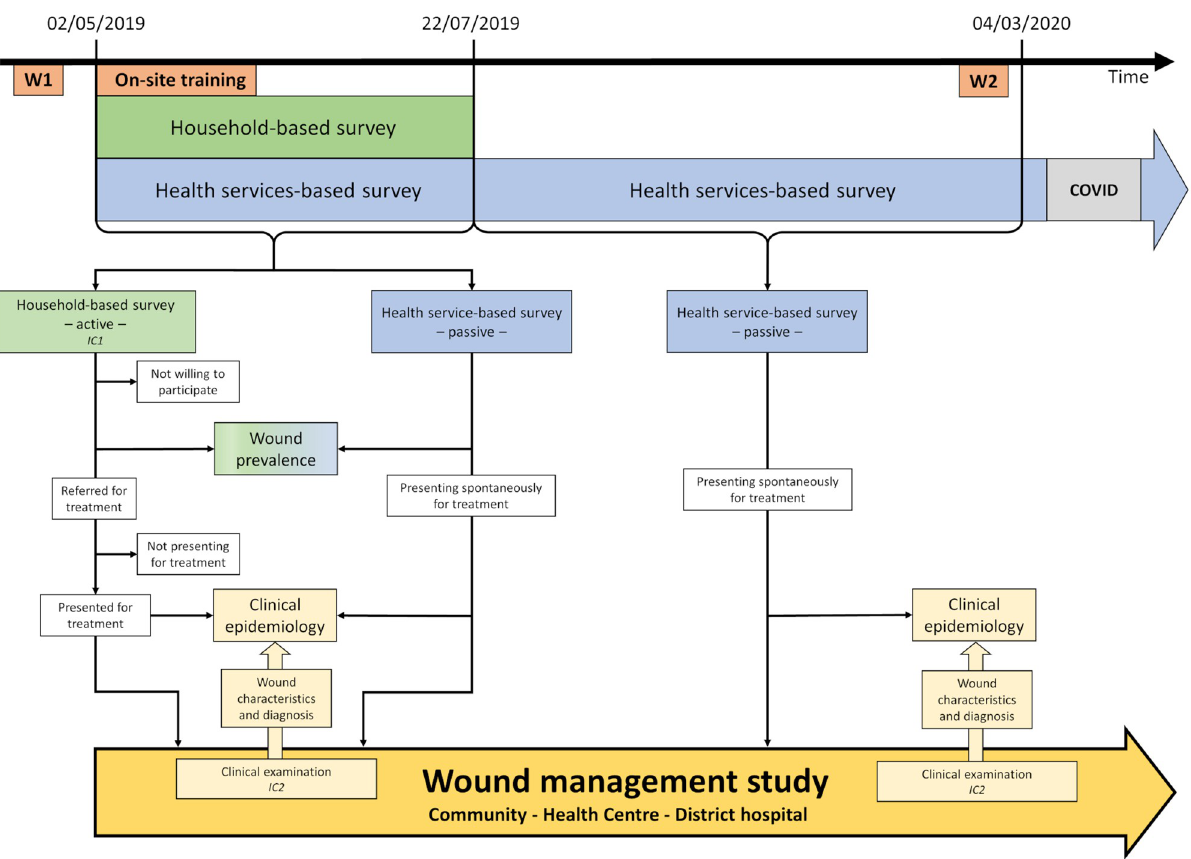
Fig 1. Study flow chart: interaction between household- and health services-based surveys and wound management study. Patients identified in the household- and health services-based surveys were offered to participate in the wound management study. The wound management study was carried out at three levels, in the community (community health workers—CHWs), health centre and district hospital according to the capability of the various levels and with the aim to identify and treat wounds as early as possible. The health staff of all three levels were trained in identifying, classifying, and treating wounds. W1 and W2: Training workshops (W) of nurses, assistant nurses, and CHWs; On-site training. IC1 and IC2: Informed consent (IC) for cross-sectional study and wound management study, respectively.